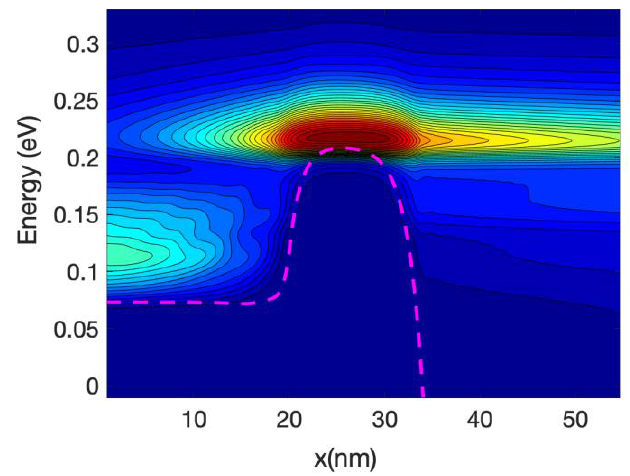
Figure 9. Close-up of Figure 8. The current spread in energy is very small at the middle of the wire or at the top of the source drain barrier. However, the spread in current increases as electrons travel towards the drain contact indicating energy relaxation. The average energy of the current is around 0.2 eV at the drain contact.